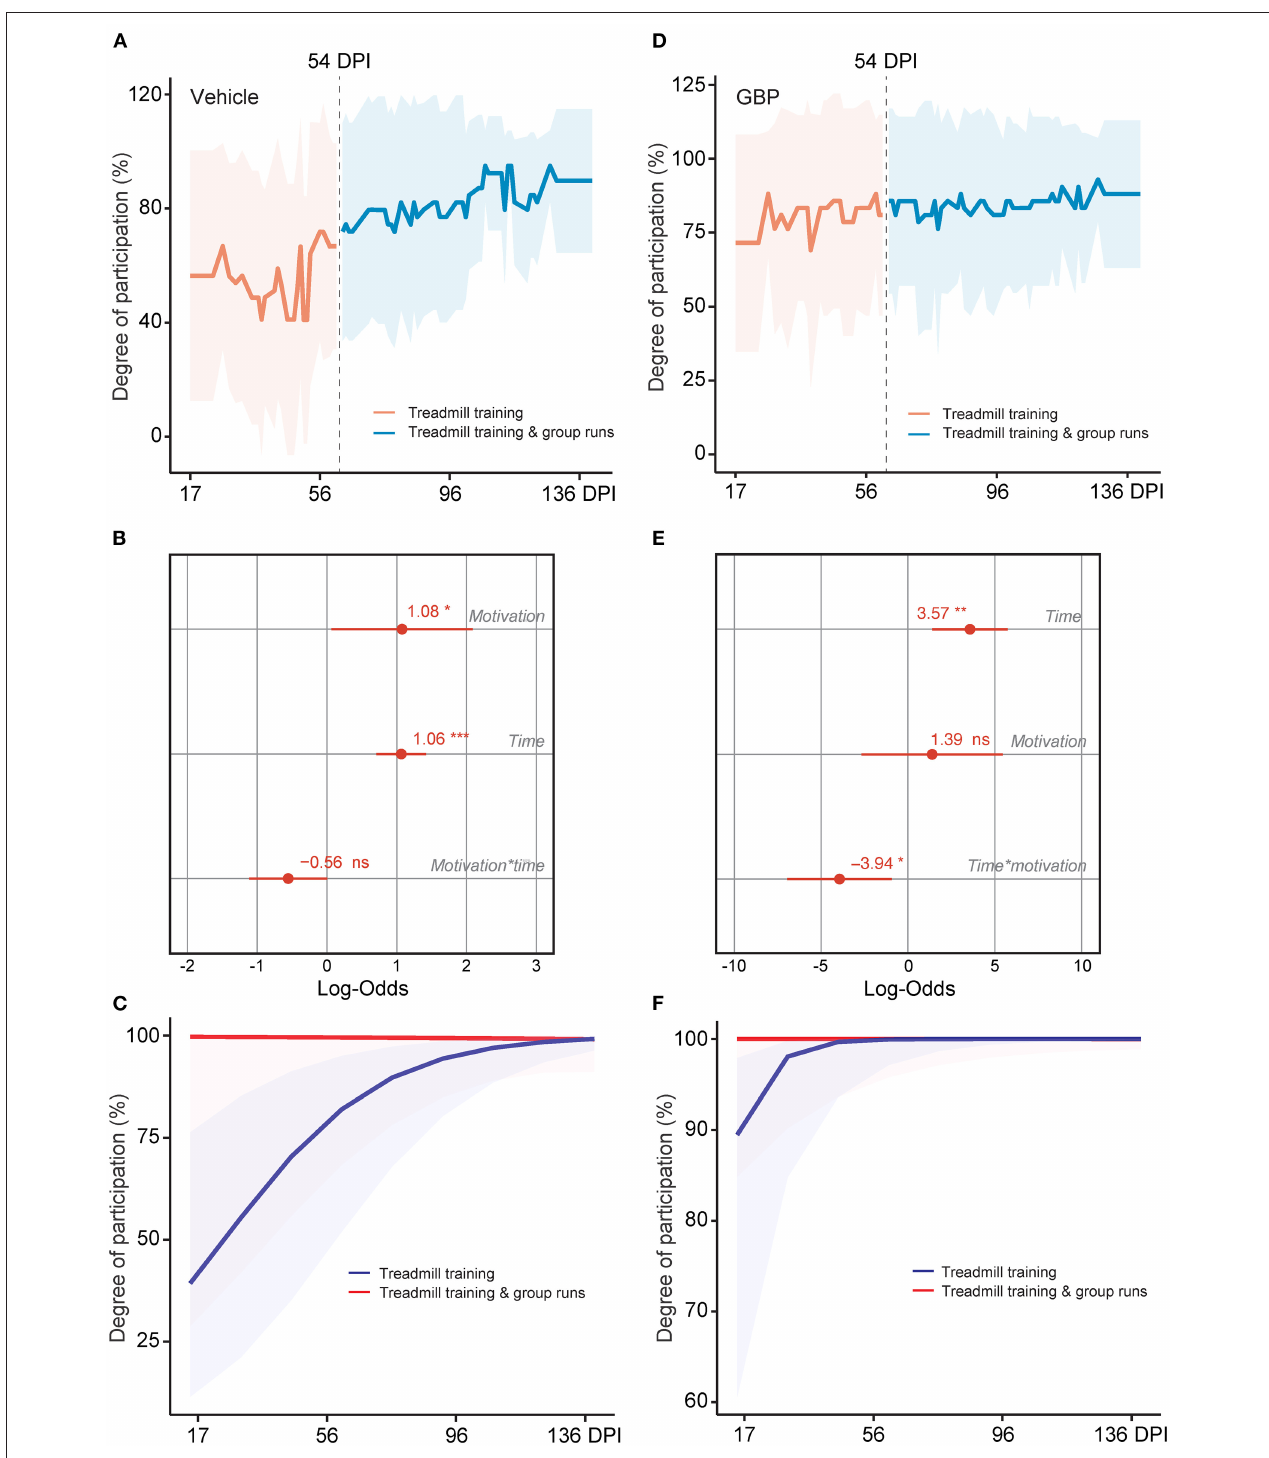
FIGURE 8 | A social motivator rescues participation in control mice, even at chronic time points. (A) Change in motivation in control mice was measured after the addition of a social motivator (e.g., group runs) into the treadmill training starting at 54 DPI. Mean and standard deviation (vehicle with treadmill training n = 13). (B) Analysis of (A) . Variable effects on motivation toward rehabilitative treadmill training in SCI mice administered vehicle are displayed as coefficients with confidence intervals (Generalized linear mixed effect model for repeated measures * p < 0.05, *** p < 0.001, ns not significant, vehicle with treadmill training n = 13). (C) Predicted changes in motivation toward the rehabilitative treadmill training in SCI mice administered vehicle. Shaded error bands indicate confidence intervals. (D) Change in